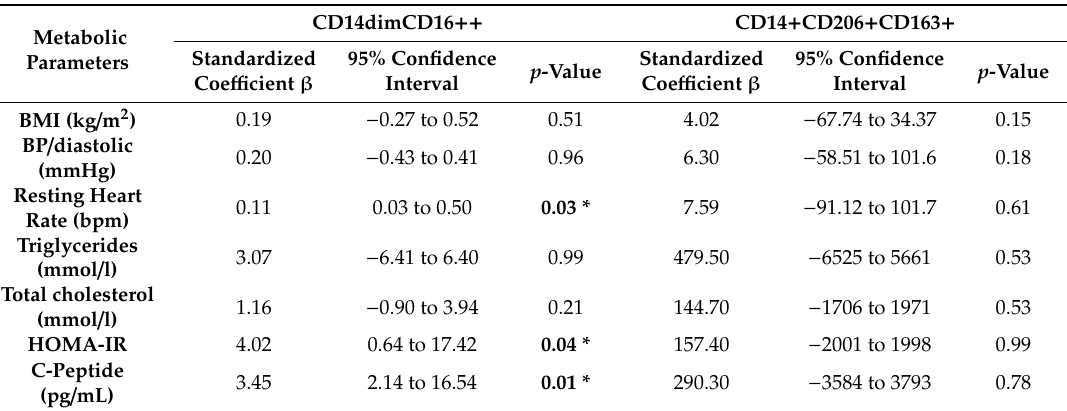
Table 5. Multiple regression analysis showing independent associations between monocyte markers expression and metabolic parameters or inflammatory